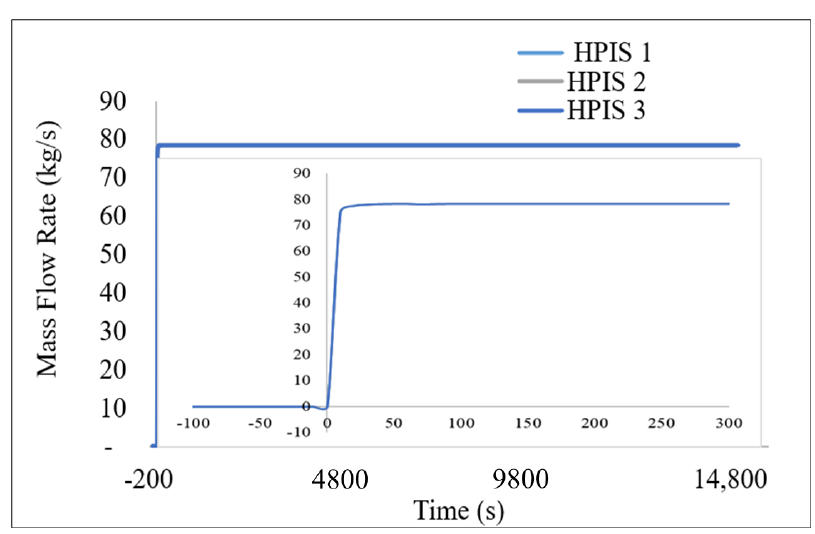
Figure 8. Injection of coolant from ACC.